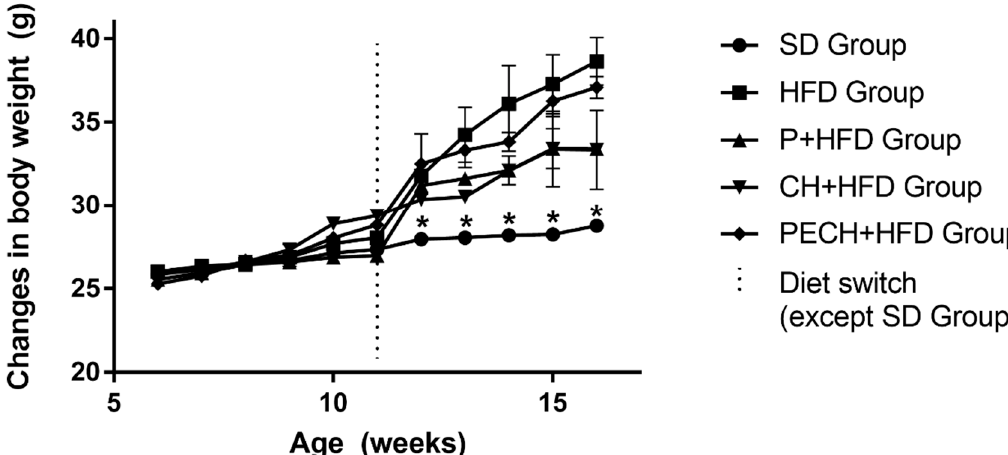
Figure 2. Changes in body weight during the study. Each group starts with SD (standard diet, n = 4) during the adaptation period. Diets were switched from SD to each high-fat diet intervention (high-fat diet (HFD, n = 8), phenolic-enriched high-fat diet (P + HFD, n = 8), lyophilized cooked ham enriched high-fat diet (CH + HFD, n = 8) and lyophilized phenolic enriched cooked ham enriched high-fat diet (PECH+HFD, n = 8) at week 11. Significant differences between SD Group and each other are expressed as * p < 0.05.